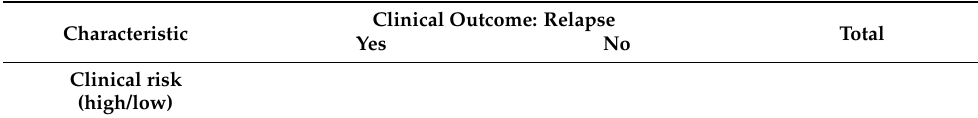
Table 5. Confusion matrix with clinical performance metrics for Modified Adjuvant!